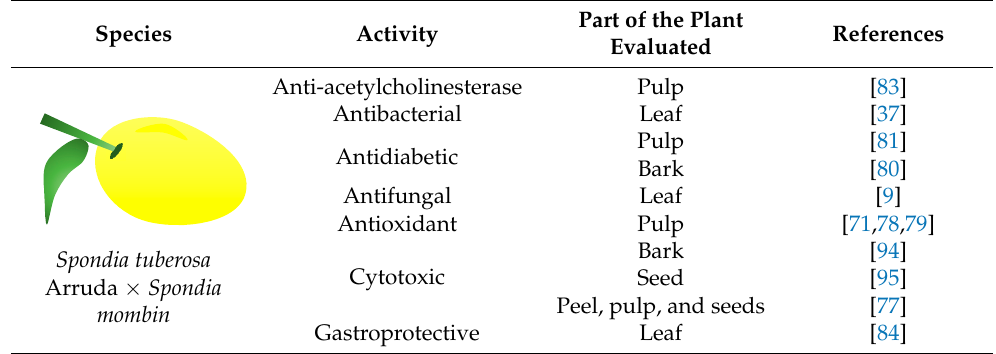
Table 6. Summary of Spondias Spondia tuberosa Arruda x Spondia mombin activity in different parts of the plant, as described in the last few years.